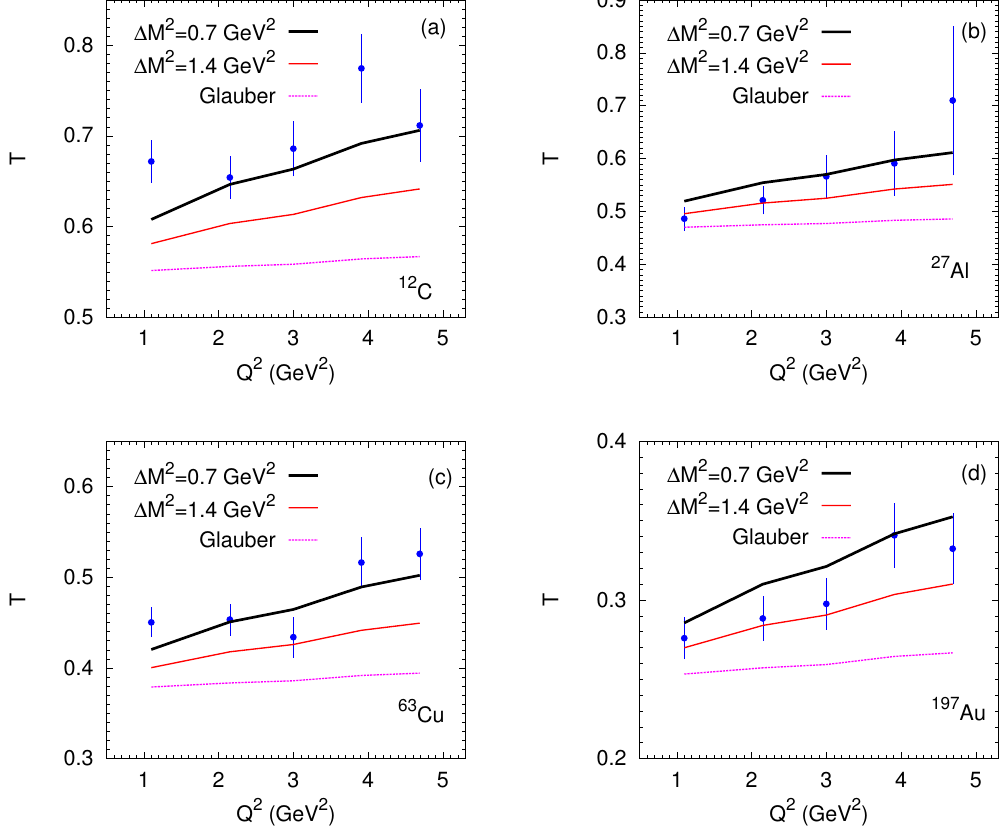
Figure 1. Transparency vs Q 2 for the ( e , e (cid:48) π + ) reaction on the carbon ( a ), aluminum ( b ), copper ( c ), and gold ( d ) targets in the collinear kinematics. Dashed (magenta) line—Glauber model; thick (black) and thin (red) solid line—quantum diffusion model (QDM) with ∆ M 2 = 0.7 and 1.4 GeV 2 , respectively. The pion momentum is p π = 2.793,3.187,3.418,4.077, and 4.412 GeV/c for Q 2 =